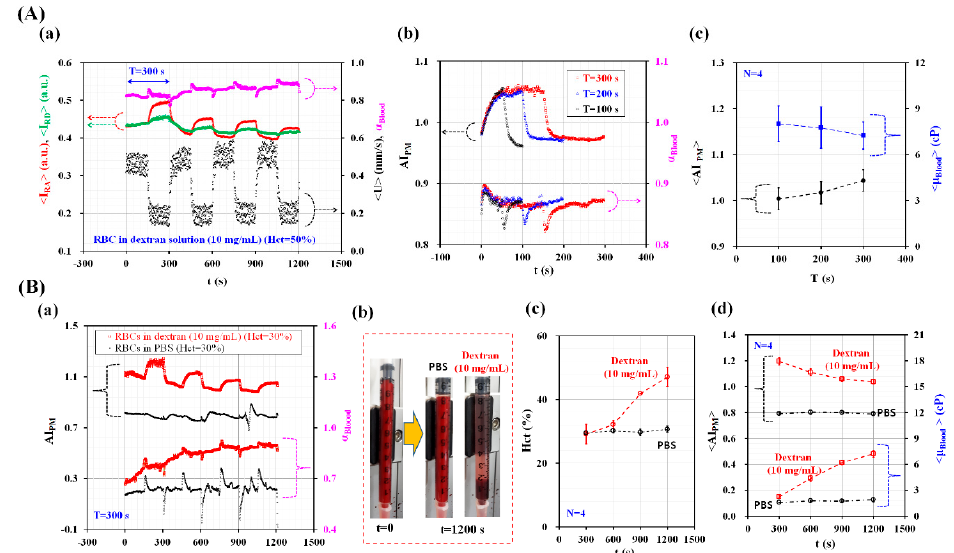
Figure 5. Quantitative evaluations of RBC aggregation index and blood viscosity under pulsatile blood flow conditions (Q max = 0.5 mL/h, Q min = 0.2 mL/h, and period (T)). Blood and PBS solution were